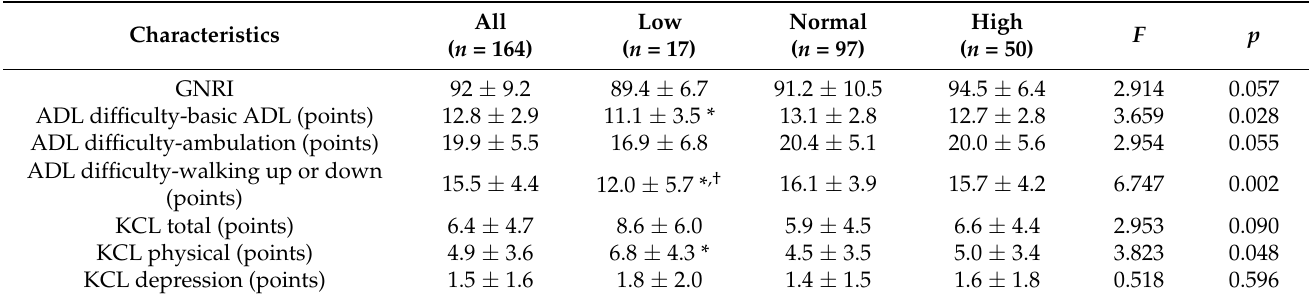
Table 3. Patients’ GNRI, ADL difficulty, and KCL